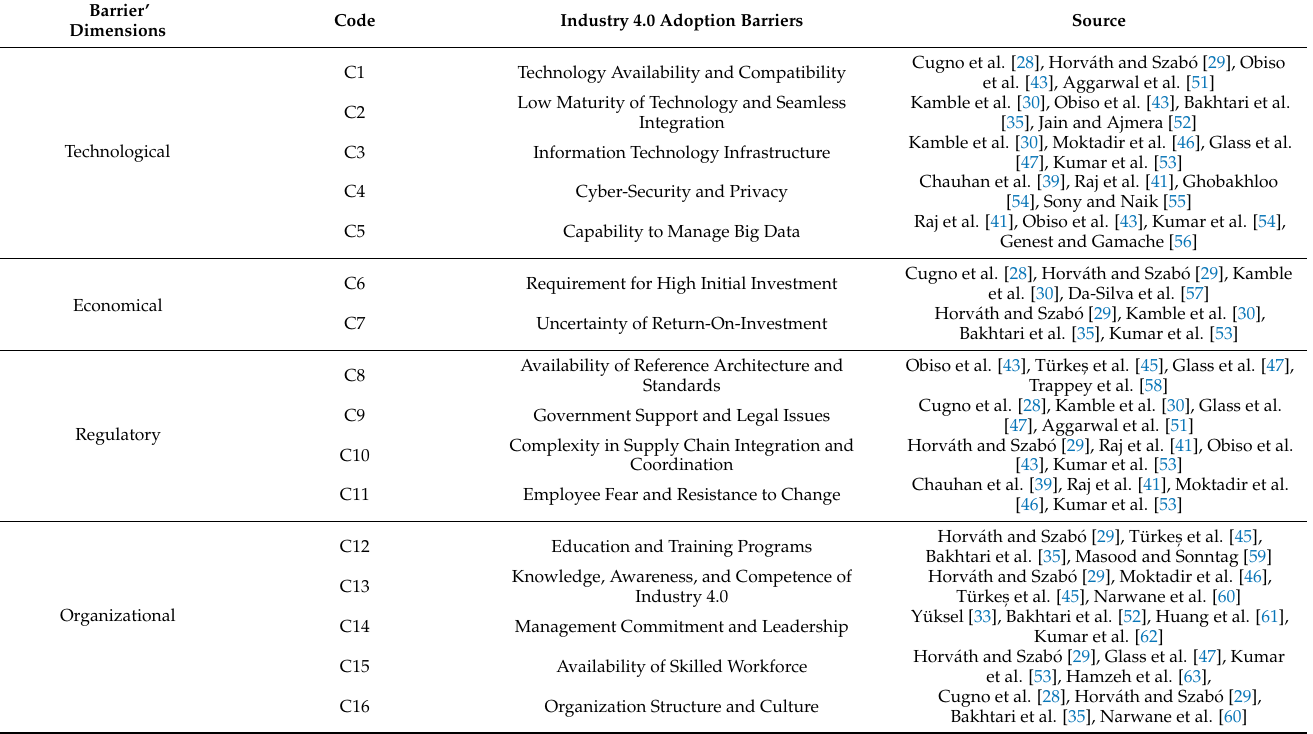
Table 1. Industry 4.0 adoption